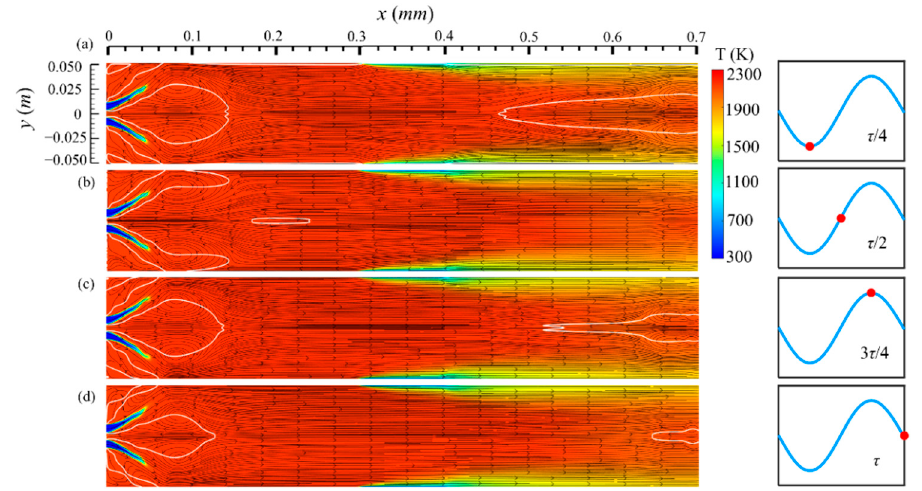
Figure 14. Temperature contour along with zero axial velocity isolines and streamlines and over a period. ( a ) τ /4 ( b ) τ /2 ( c ) 3 τ /4 and ( d ) τ at T H = 500 K, where S N = 0.45, V a = 180 L/min and T i = 300 K.